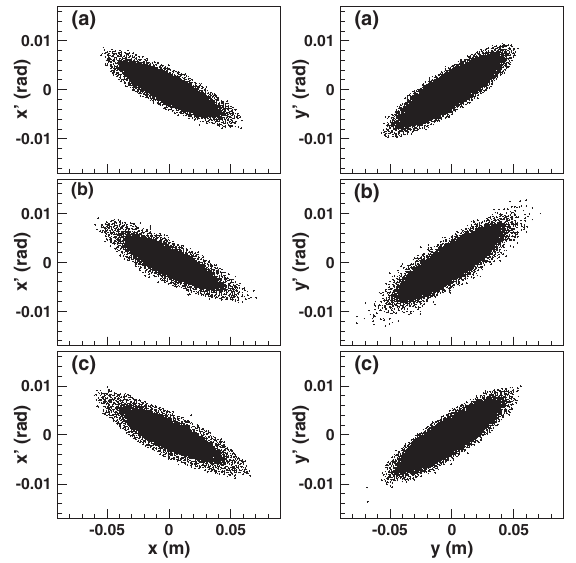
FIG. 32. Two-dimensional transverse phase space coordinates at the end of injection calculated with ϵ tp ¼ 150 π mm mrad for the beam intensity of 850 kW, where three kinds of transverse beam distributions are given; (a) without edge focus, (b) with edge focus, and (c) with the addition of QDTs to